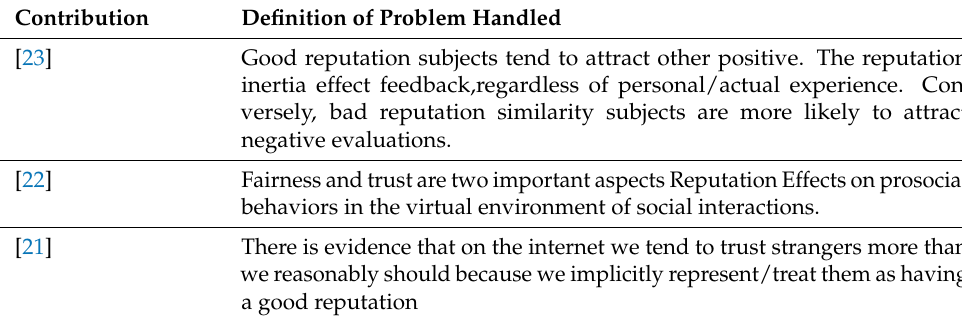
Table 1. Summarization of contributions under the reputation concept.